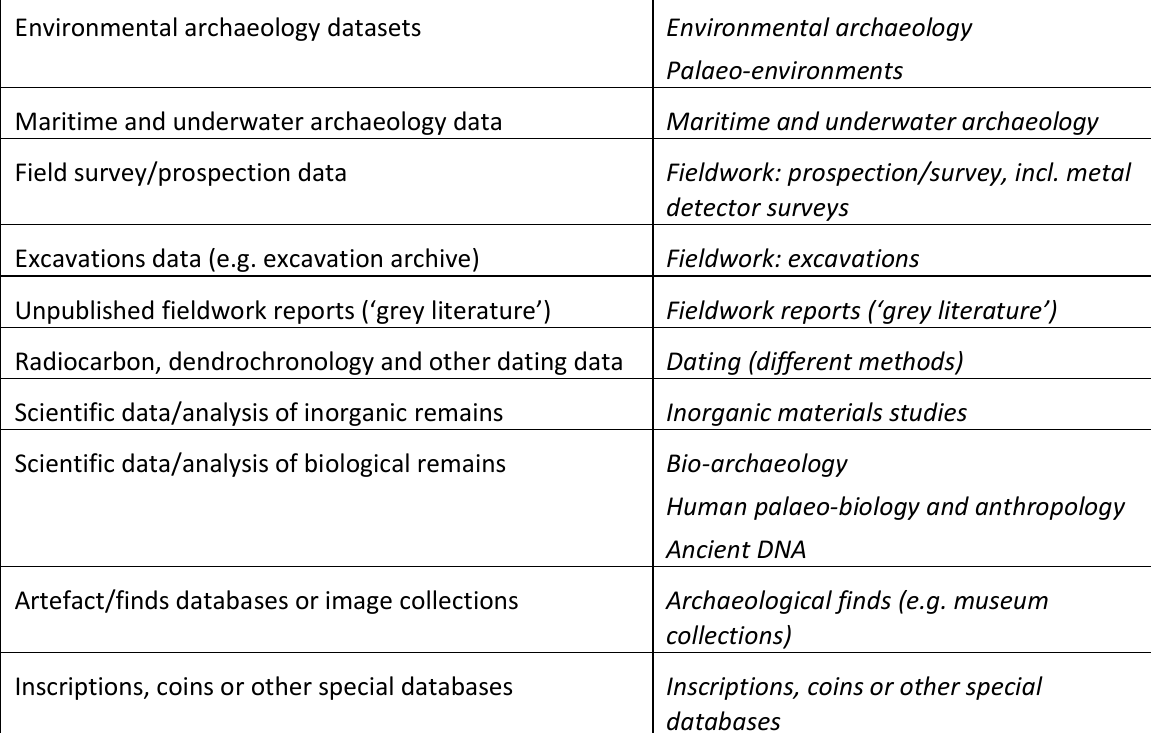
Table 15 : Mapping of data types in the survey and ARIADNEplus data types.